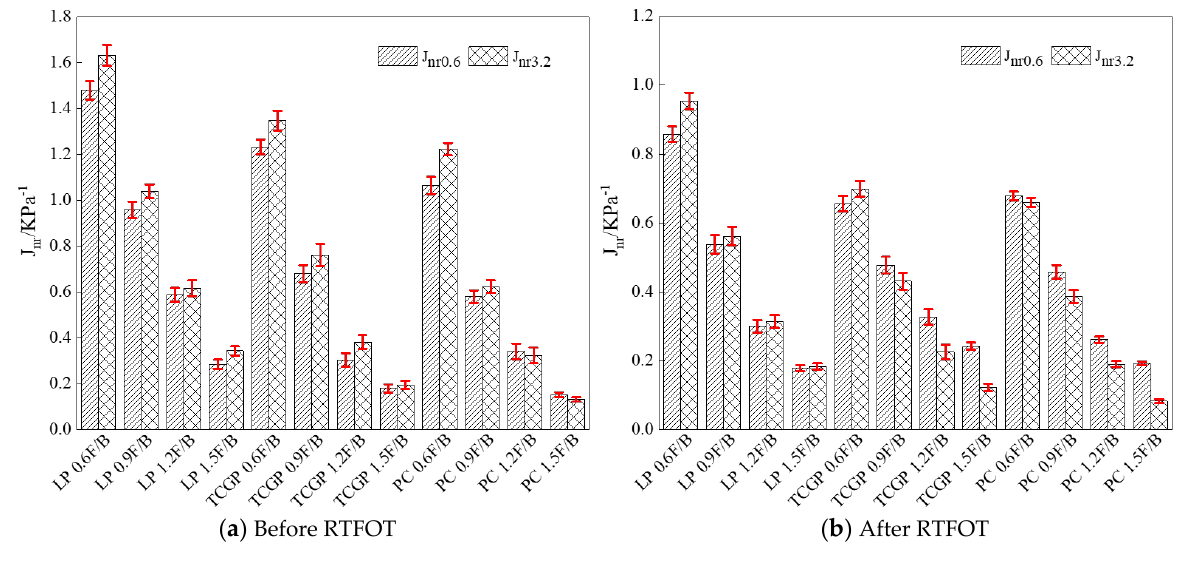
Figure 11. Test results of J nr of different emulsified asphalt mastics (64 ℃ ).